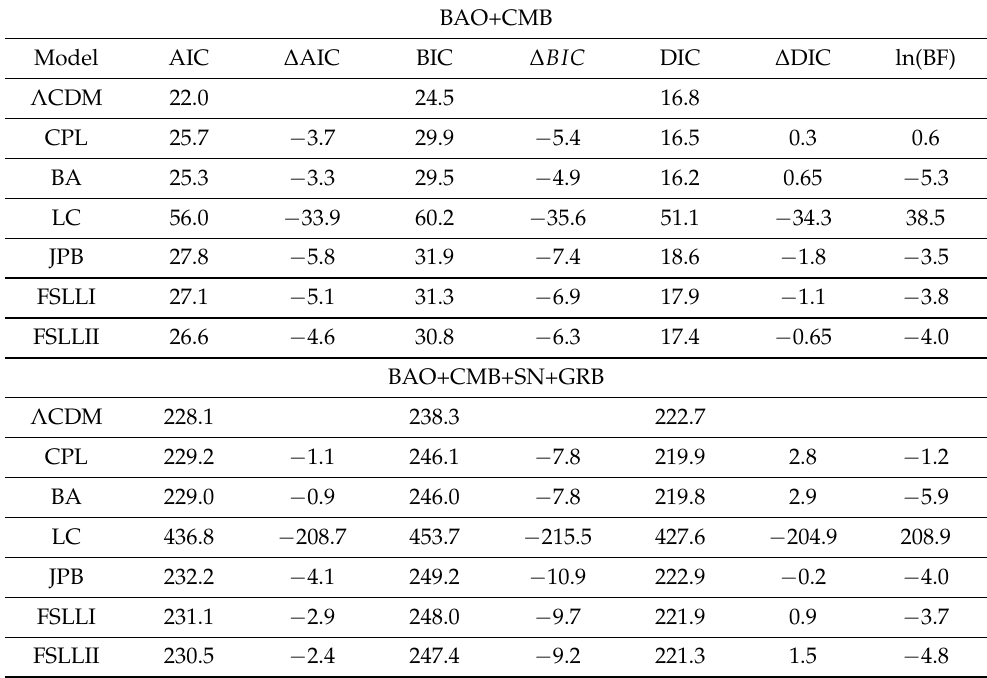
Table 1. Selection criteria of different models in a comparison to the Λ CDM model for the BAO dataset and the BAO+SN+GRB dataset.